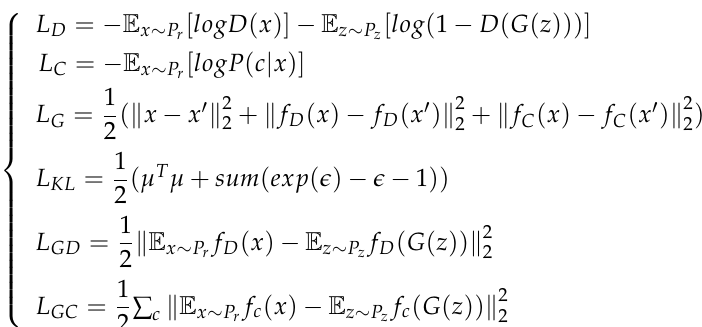
Figure 3. Illustration of a CVAE-GAN model.